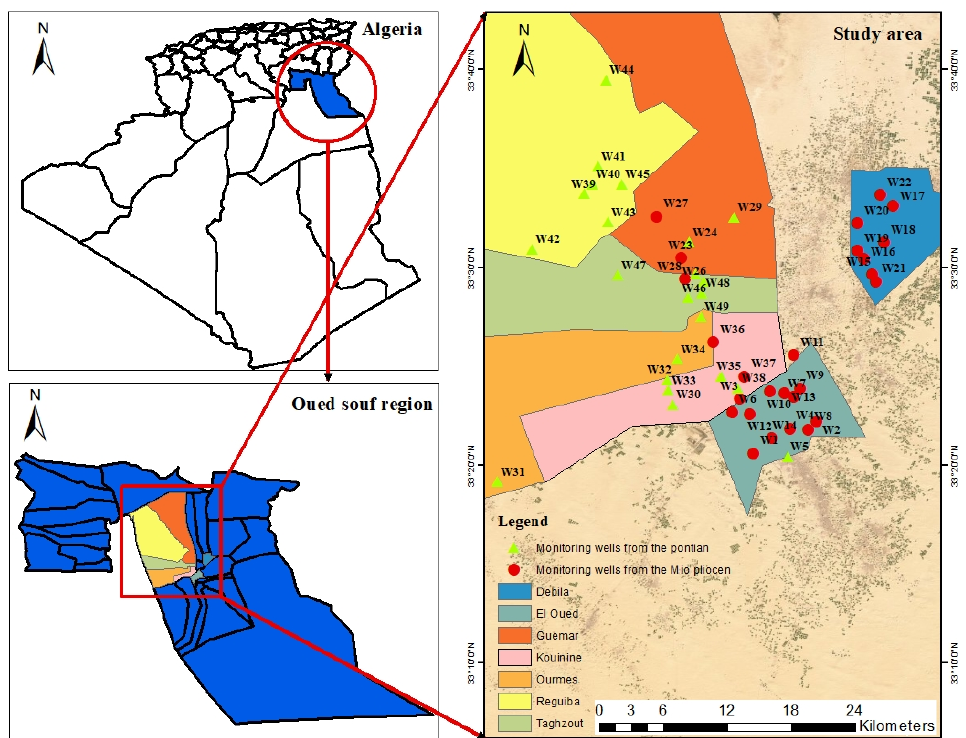
Figure 1. Location map of the study area illustrating the distribution of the monitoring wells.